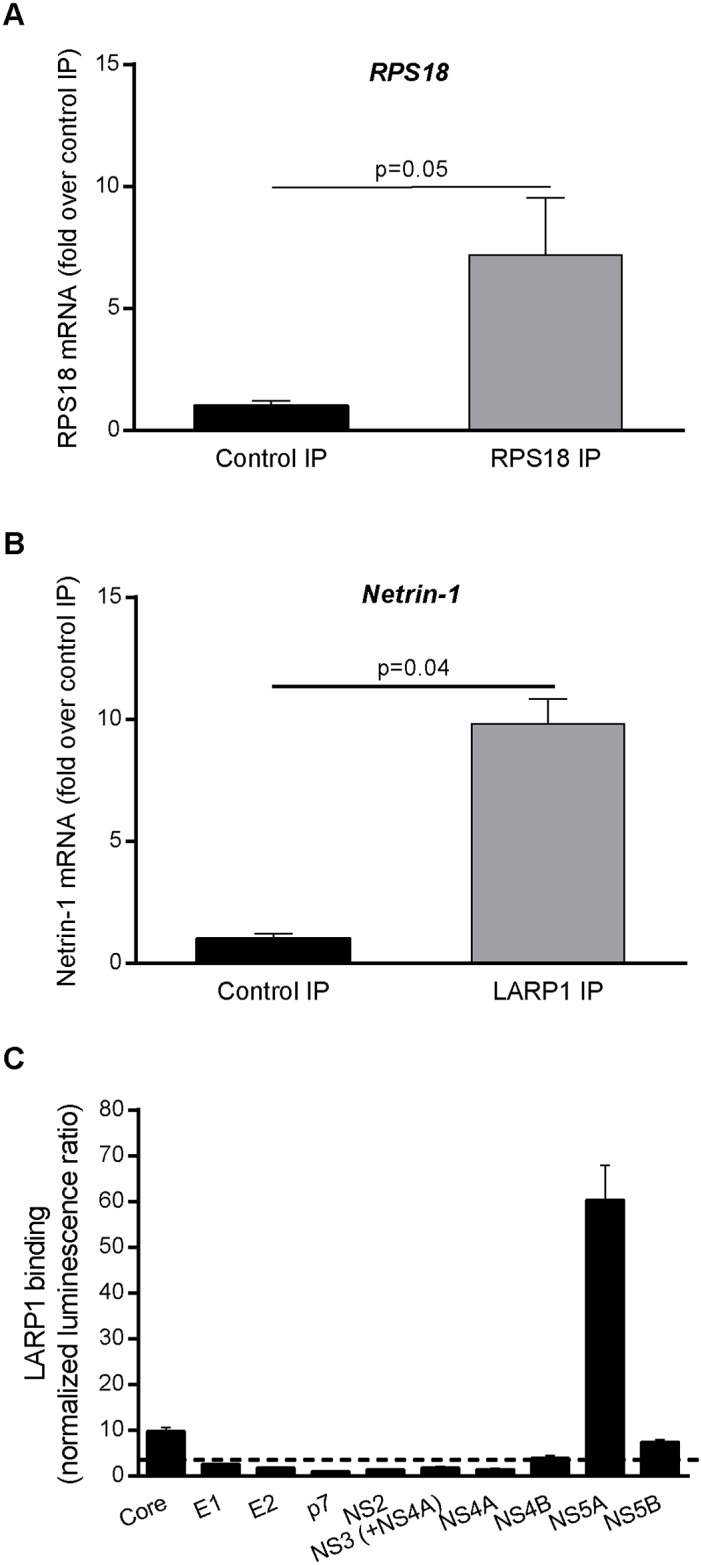

Netrin-1 mRNA and HCV NS5A are LARP1 interactants.Quantification of ribosomal protein S18 (RPS18) (A) and Netrin-1 (B) mRNA by qPCR after immunoprecipitation using LARP1 antibody (data are represented as mean ± standard deviation, n = 3, Mann-Whitney test, p < 0.05). C. Huh-7.5 cells were cotransfected with a Gluc1-LARP1 plasmid and individual plasmids encoding Gluc2 fused to the indicated HCV proteins and subjected to luciferase assays. Y-axis represents normalized luminescence ratio (NLR). The dashed line represents background level measured using a 53-protein random reference set. Data represent means ± standard deviations (error bars) from three independent experiments in triplicates. The underlying data for panels in this figure can be found in S1 Data.